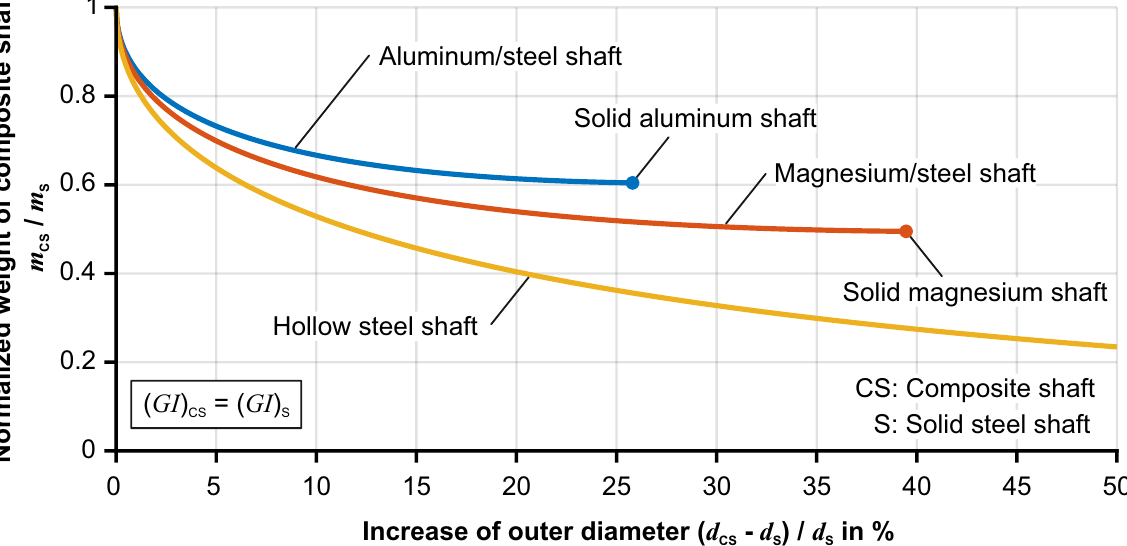
Figure 3. Mass savings for substituting a solid steel shaft by composite shafts with aluminum core, magnesium core and hollow shafts with identical torsional